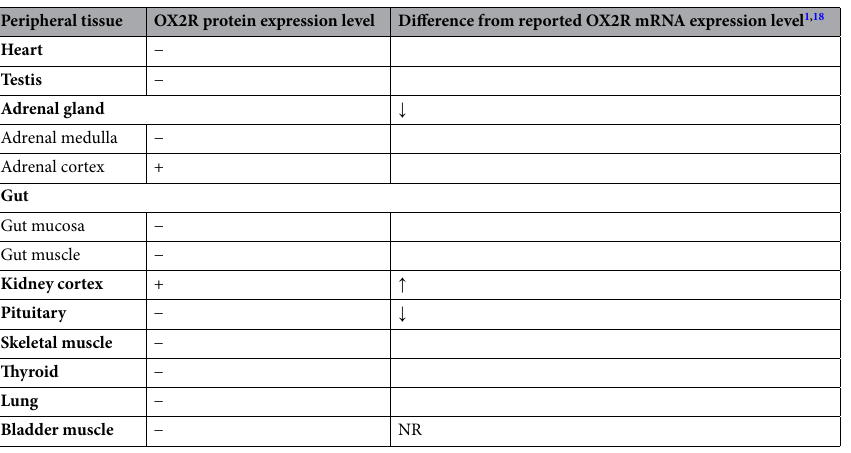
Table 2. Relative densities of [ 3 H]-EMPA binding for OX2R protein expression in rat peripheral tissue sections. Qualitative estimates of OX2R protein expression are presented based on the relative optical density (ROD) values for [ 3 H]-EMPA binding (Supplementary Table S2). The following scale was used: +, low density (1 ≤ ROD < 4); −, nearly undetectable density (ROD < 1). Difference from reported OX2R mRNA expression 1,18 is also depicted. A relatively higher or lower protein expression than the reported mRNA expression is indicated by “ ↑ ” or “ ↓ ”, respectively. No reported data for mRNA expression in comprehensive assessments is represented as